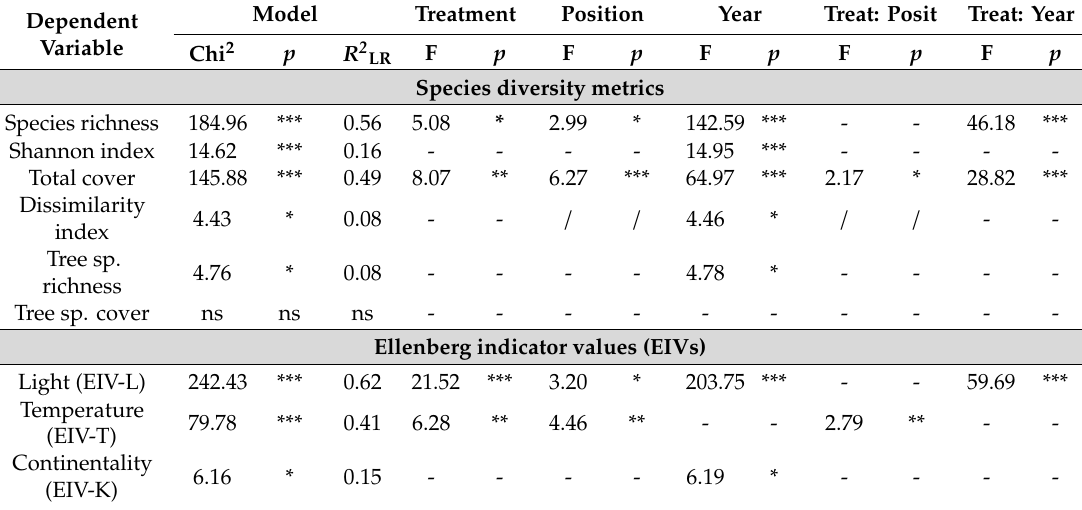
Table 1. Results from linear mixed-e ff ect models for diversity metrics, plot-level Ellenberg indicator values (EIVs), and community-weighted trait means (CWMs) of plant functional traits. “-” indicates that factor or interaction term was not included in the final model. Interaction between position and year is not shown as it was not significant in any of the models. SLA—specific leaf area, LDMC—leaf dry matter